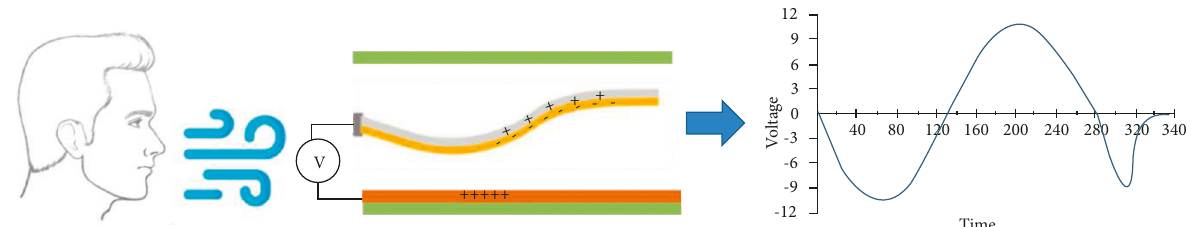
Figure 4: A schematic illustration of the respiratory mechanical monitoring